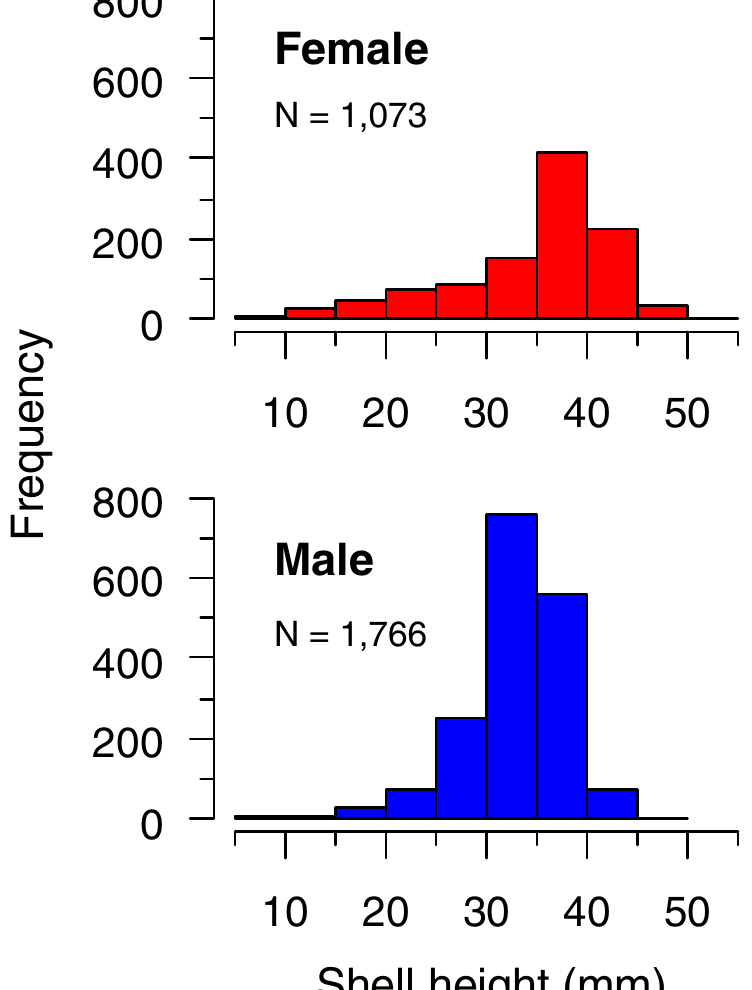
Figure 3. Shell height composition of crawling Laguncula pulchella individuals collected in Matsukawaura Lagoon between 2015 and